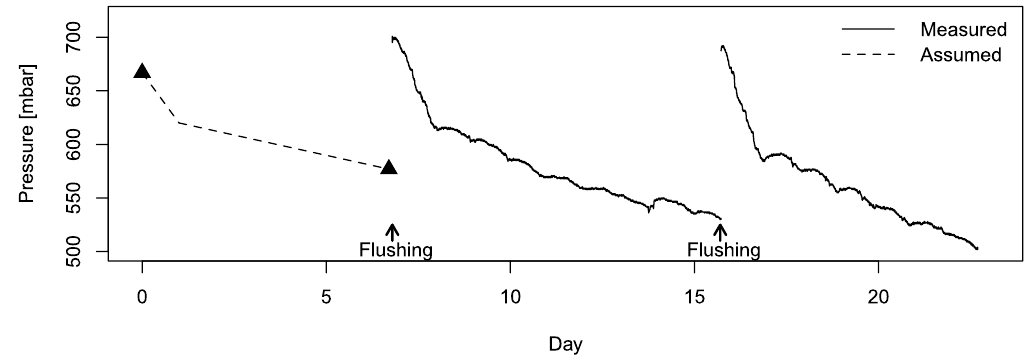
Figure 8. Inlet pressure change due to filter clogging over time. The starting and ending pressure levels ( (cid:78) ) in the first week were recorded manually.